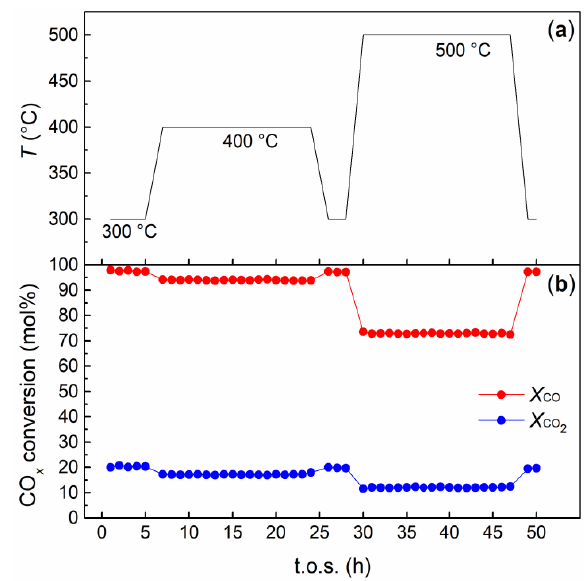
Figure 6. Thermal stability test for Ni/Ce 0.50 Zr 0.50 O 2 in the CO x co-methanation reaction: ( a ) Reactor temperature profile; ( b ) CO conversion (X CO ) and CO 2 conversion (X CO2 ) vs. time-on-stream (t.o.s.). CO / CO 2 / H 2 = 1 / 1 / 5; SV = 150,000 cm 3 h − 1 g cat − 1 .